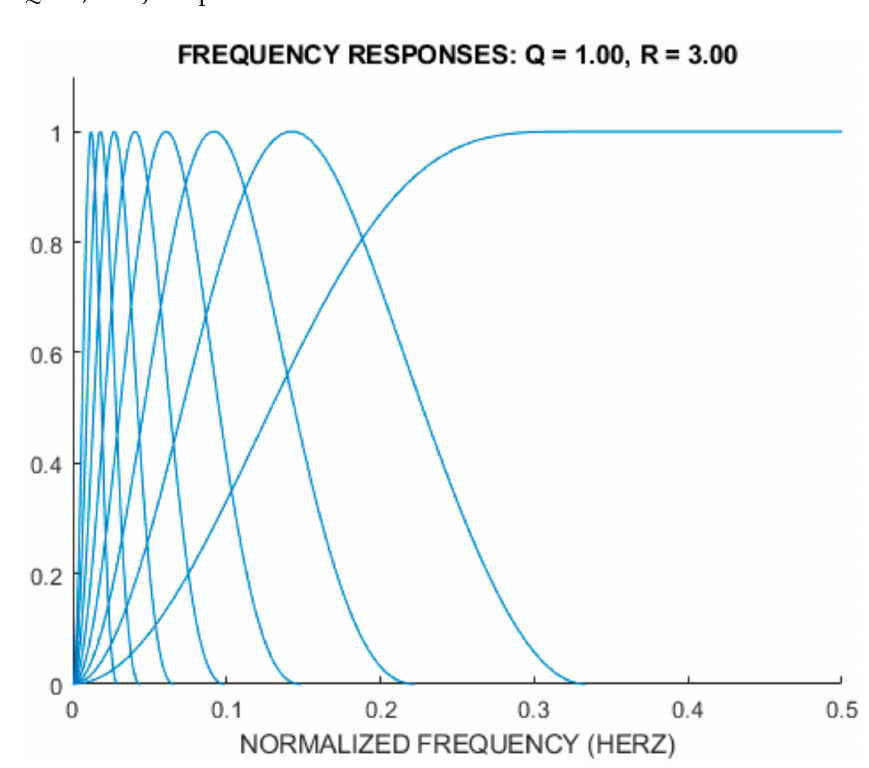
Figure 5. The frequency response for TQWT with the R = 3, Q = 1, and J = 8 parameters.